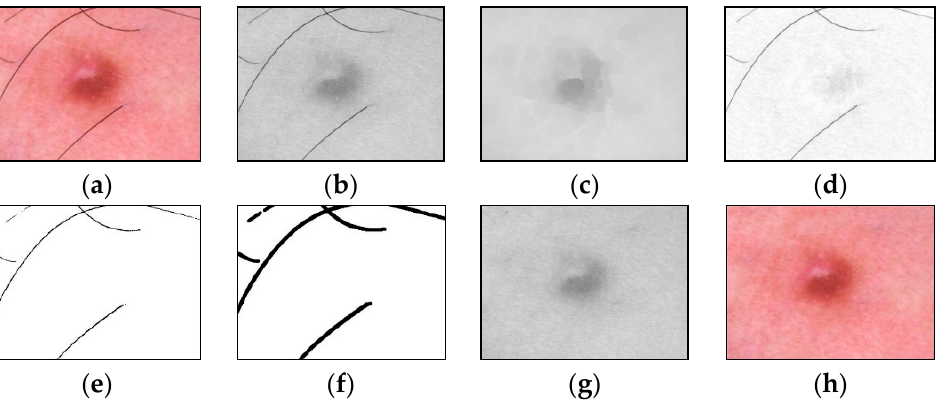
Figure 4. Images obtained as a result of passing each stage of the method of identification and hair removal: (a ) input RGB image P RGB ; ( b ) the color component P R , presented in shades of gray; ( c ) the result of the H R 3 closing operation; ( d ) the result of the subtraction operation H R 2 (inverted image); ( e ) the result of zeroing pixels H R 1 (inverted image); ( f ) the result of the H R dilatation operation (inverted image); ( g ) pixel interpolation result P R ∗ ; ( h ) output RGB image P RGB ∗ . Scale bar magnification. or